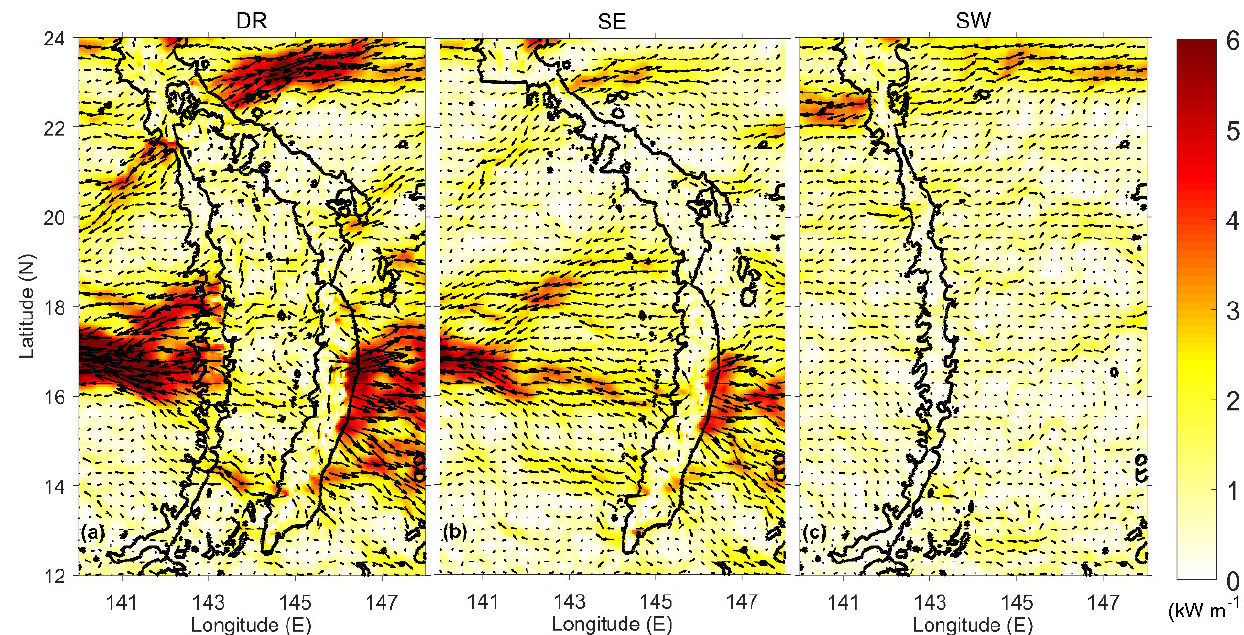
Figure 5. Depth-integrated baroclinic energy flux (vector) and its magnitude (color shading) (kW m –1 ) under ( a ) for DR case, ( b ) for SE case, and ( c ) for SW case. The background contours represent the 3000-m isobaths.